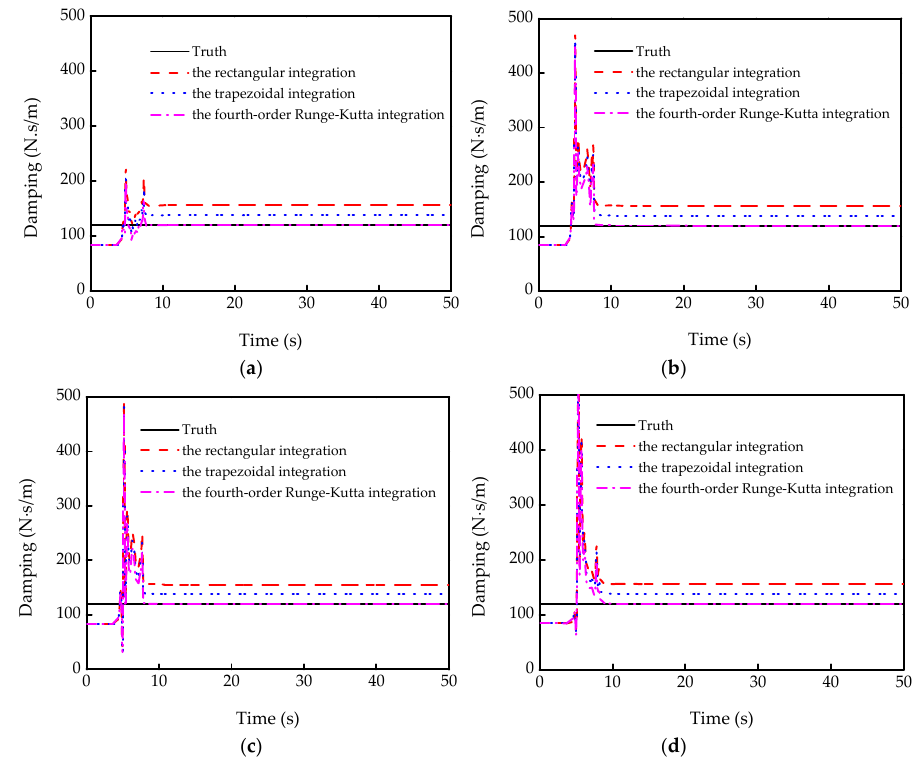
Figure 5. Damping estimation by three integration methods: ( a ) the 1 st story; ( b ) the 2 nd story; ( c ) the 3 rd story; ( d ) the 4 th story.